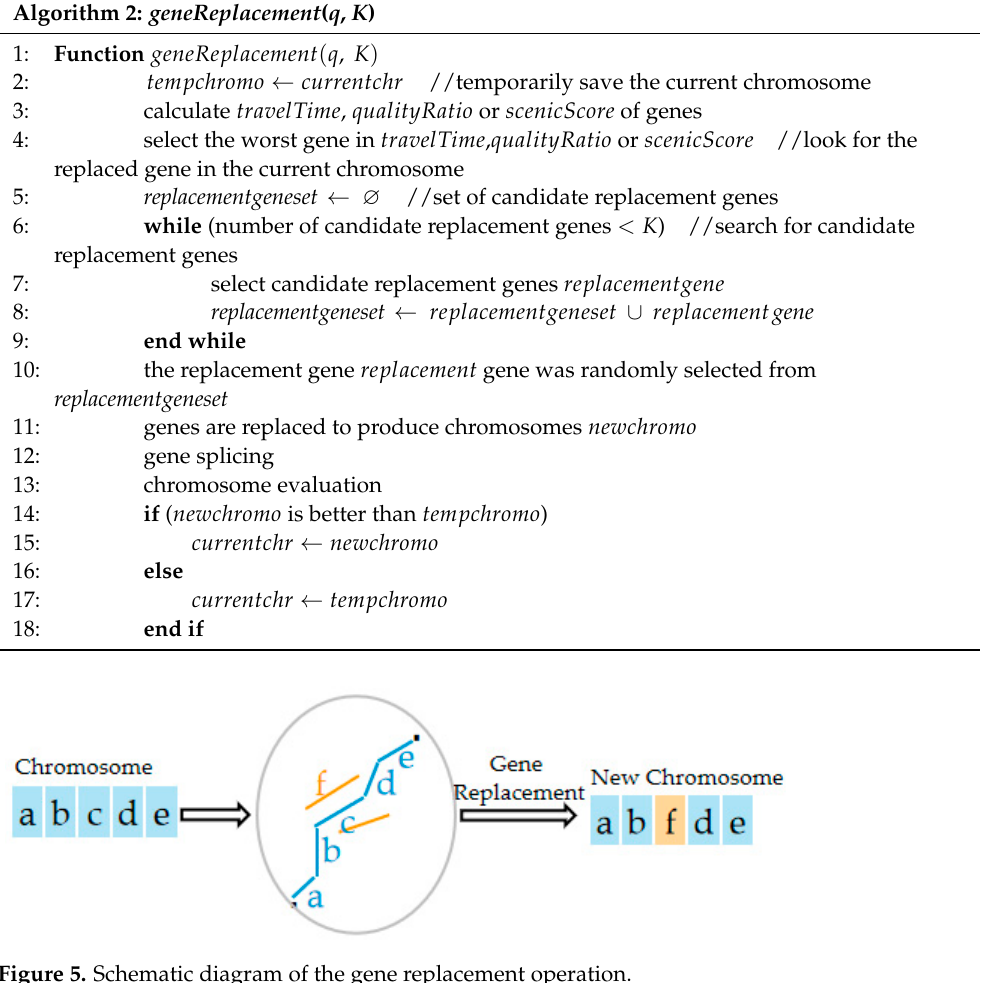
Algorithm 2: geneReplacement ( q , K )